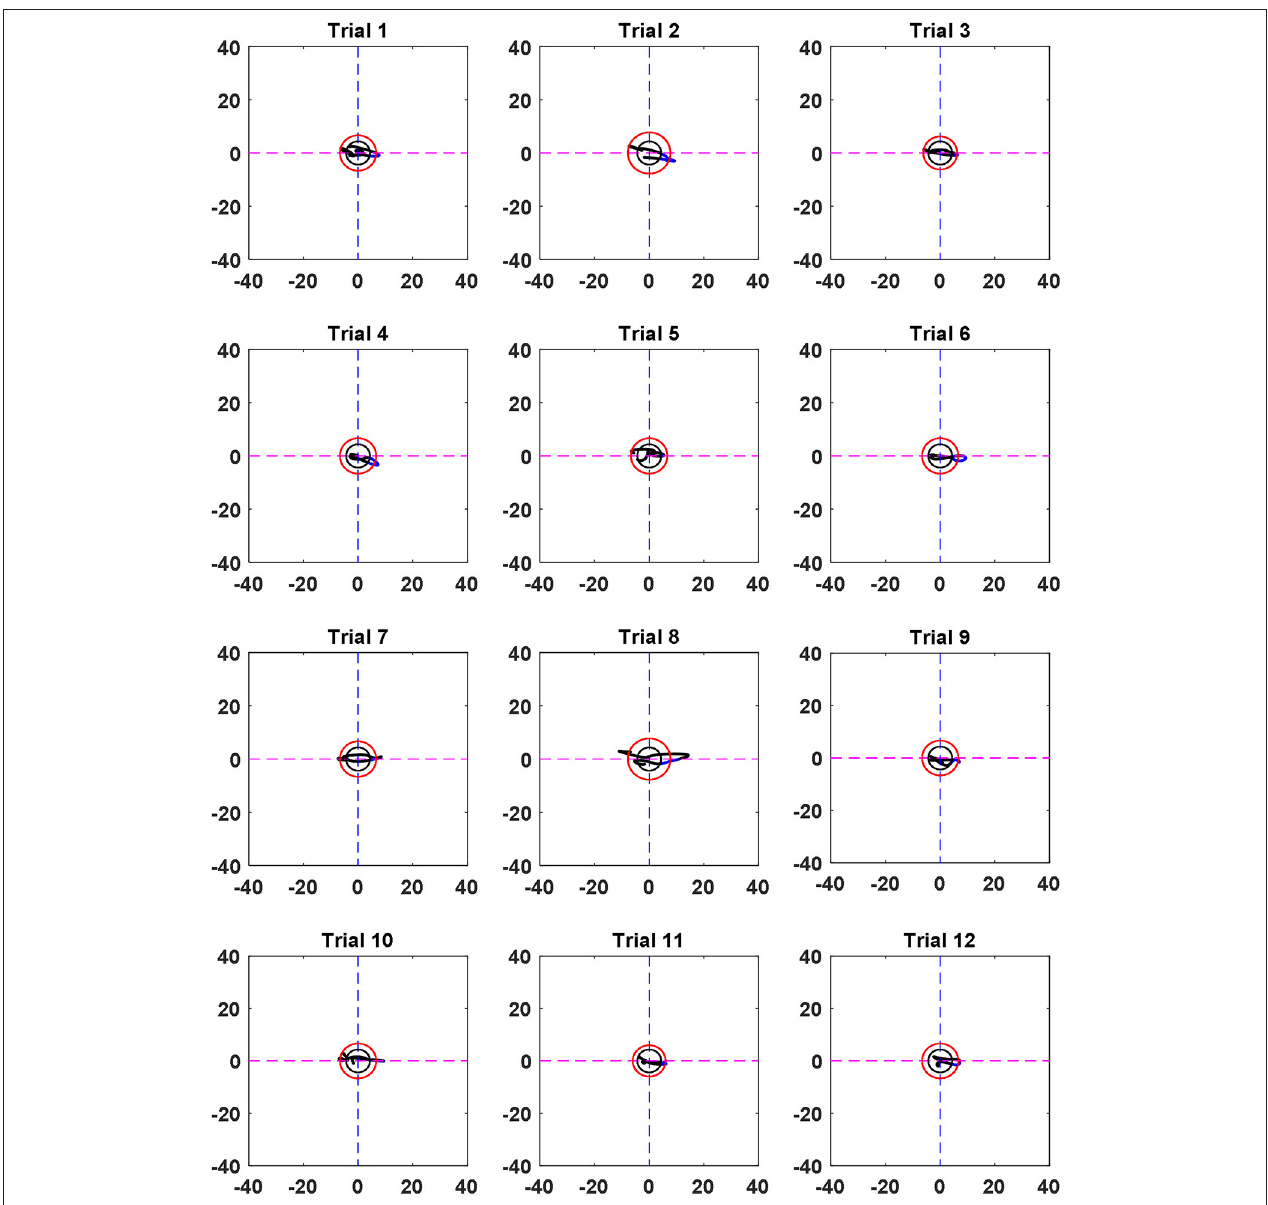
FIGURE 8 | Trajectories of all 12 trials at Ch. 21 (Sub.